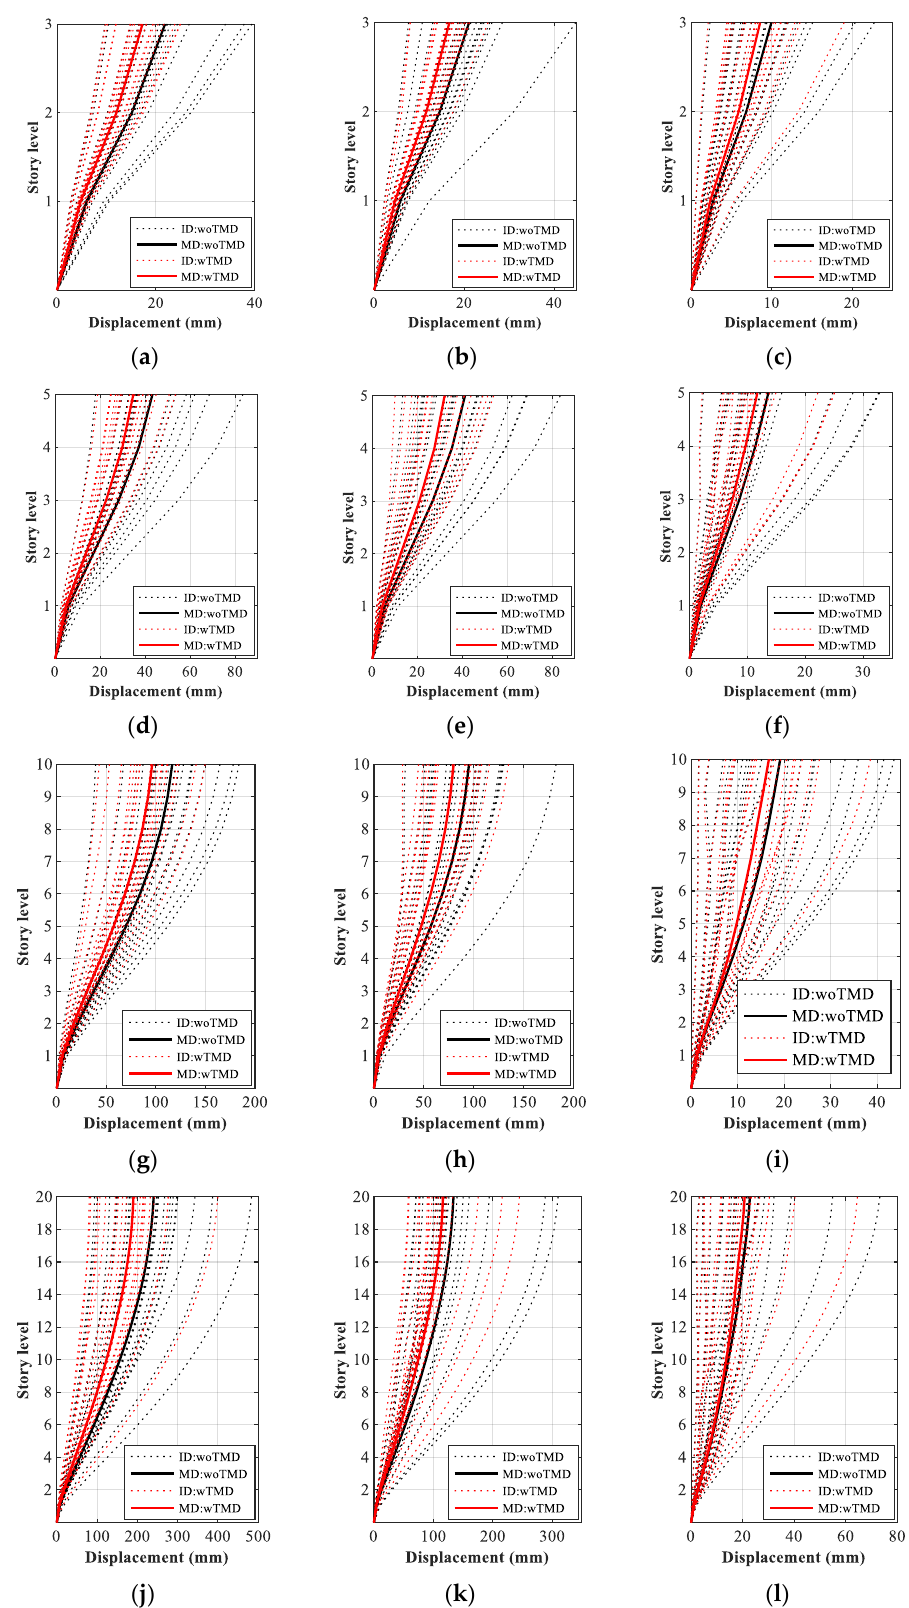
Figure 11. Story displacement of building frames under different categories of GMs: ( a ) 3 story (LFC); ( b ) 3 story (MFC); ( c ) 3 story (HFC); ( d ) 5 story (LFC); ( e ) 5 story (MFC); ( f ) 5 story (HFC); ( g ) 10 story (LFC); ( h ) 10 story (MFC); ( i ) 10 story (HFC); ( j ) 20 story (LFC); ( k ) 20 story (MFC); ( l ) 10 story (HFC).